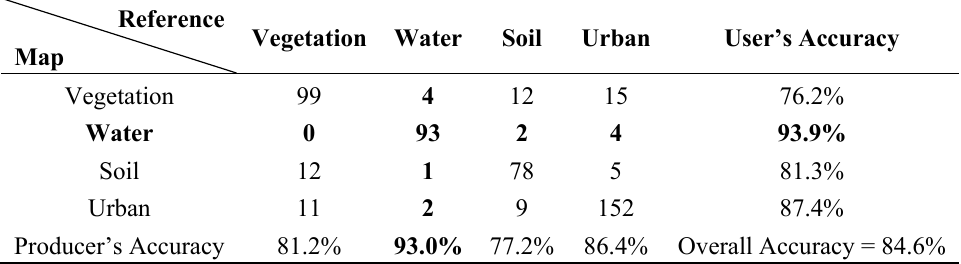
Table 2. Error matrix for before-Katrina classification, Neural Network classifier.